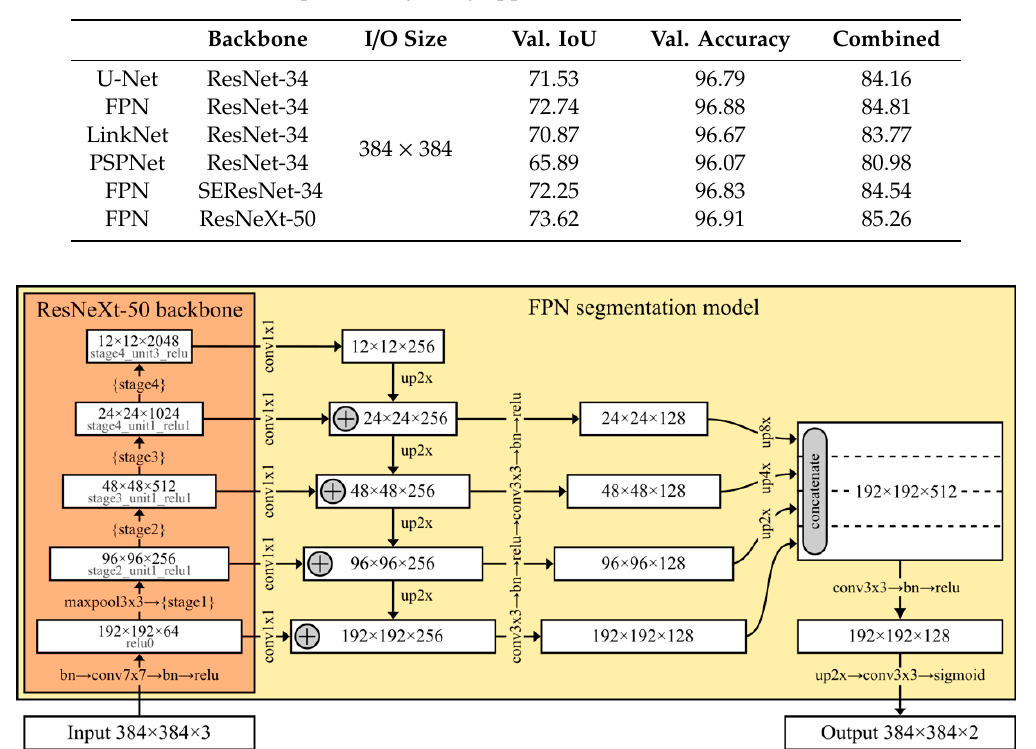
Table 1. Results of the preliminary study applied to select the architecture and backbone.